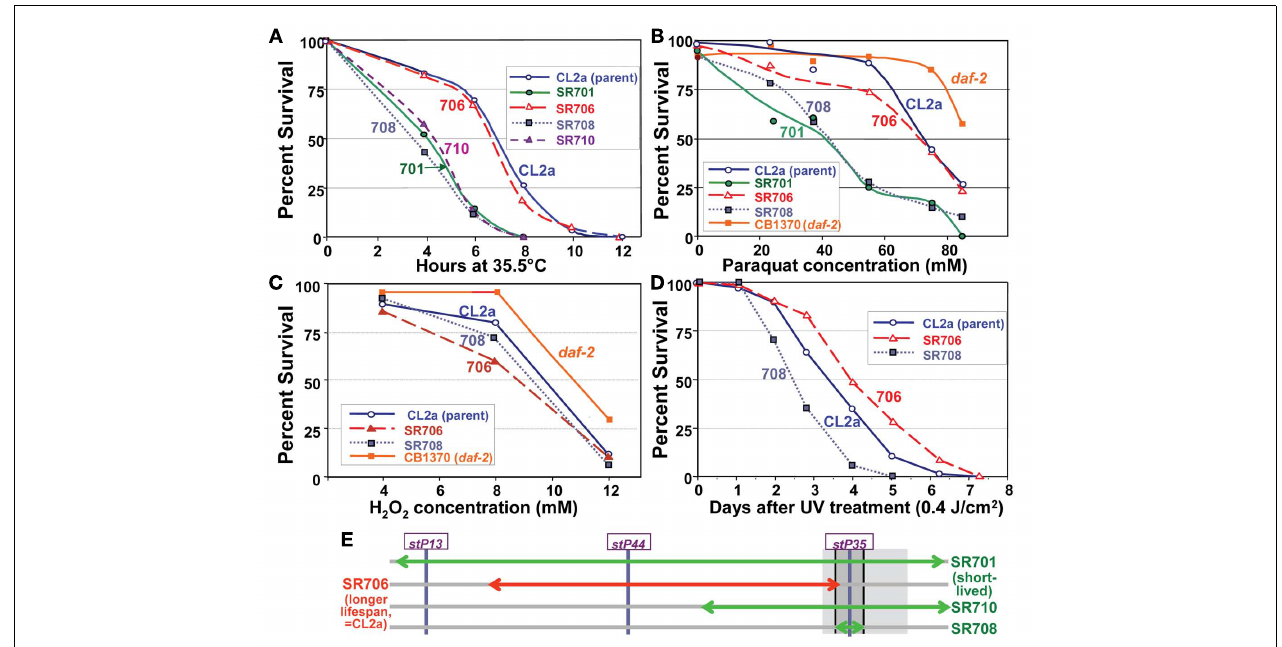
post-hatch were transferred in groups of 30 to liquid survival medium without E. coli . After 30min for digestion of enteral bacteria, paraquat was added to a final concentration of 0–85mM and replaced daily, with assessment after 3days at 20˚C. (C) Hydrogen peroxide resistance assays. Congenic and recombinant-congenic lines, and parental strain CL2a, were exposed to varying concentrations of hydrogen peroxide (0, 4, 6, 8, 10, and 12mM). Mature adult hermaphrodites were treated and the number of live worms was counted after 4h of continuous exposure. (D) Survival of ultraviolet (UV) irradiation. Groups of 30 worms, 4days post-hatch, were placed on agar plates without food at 20˚C, and exposed to ultraviolet light at 0.4joules/cm 2 .Worms were transferred to fresh plates seeded with E. coli (var. OP50); viability was assessed as above at 20.0 ± 0.4˚C, at 1-day intervals. (E) Schematic of QTL-mapping data for resistance to temperature shift, paraquat or